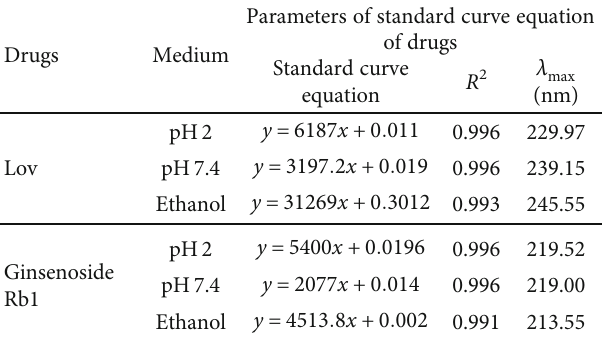
Table 2: LOV and ginsenoside Rb1 standard curve equations in di ff erent pH solutions and in ethanol.